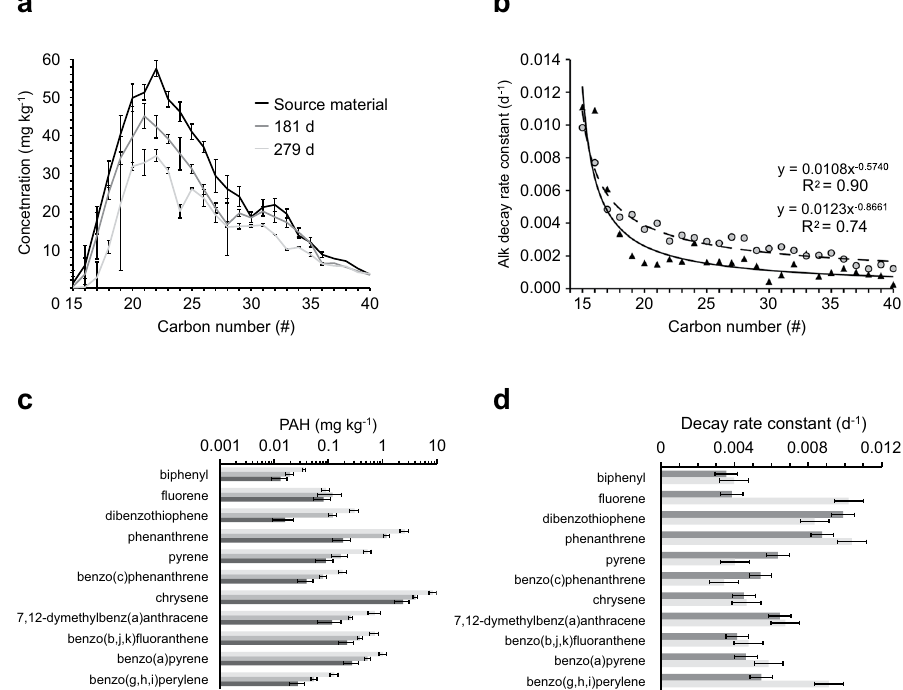
Figure 5. Alkane and PAH degradation in the sSRBs during the experiment. ( a ) Alkane concentrations in the sSRBs at the beginning of the experiment and after 0.5 and 0.75 years. Error bars depict standard deviation. ( b ) Comparison of n -alkane decay rate constants in sSRBs (0.75-year decay rates, black triangles, solid line) and sSOAs (0.75-year decay rates, grey circles, dotted line). ( c ) PAH concentrations in the sSRBs at the start of the experiment (light gray) and after 0.5 (medium gray) and 0.75 years (dark gray). Error bars depict one standard deviation. Note logarithmic scaling of the X-axis. ( d ) Comparison of 0.75-year sSRB (dark grey bars) and sSOA (light grey bars) PAH decay rate constants. Error bars depict standard